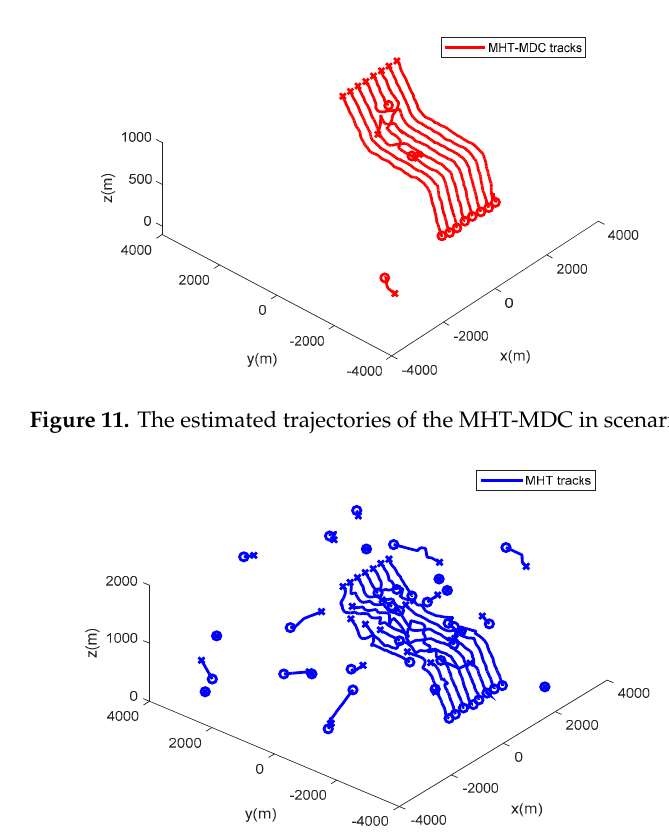
Figure 12. The estimated trajectories of the MHT in scenario 2.